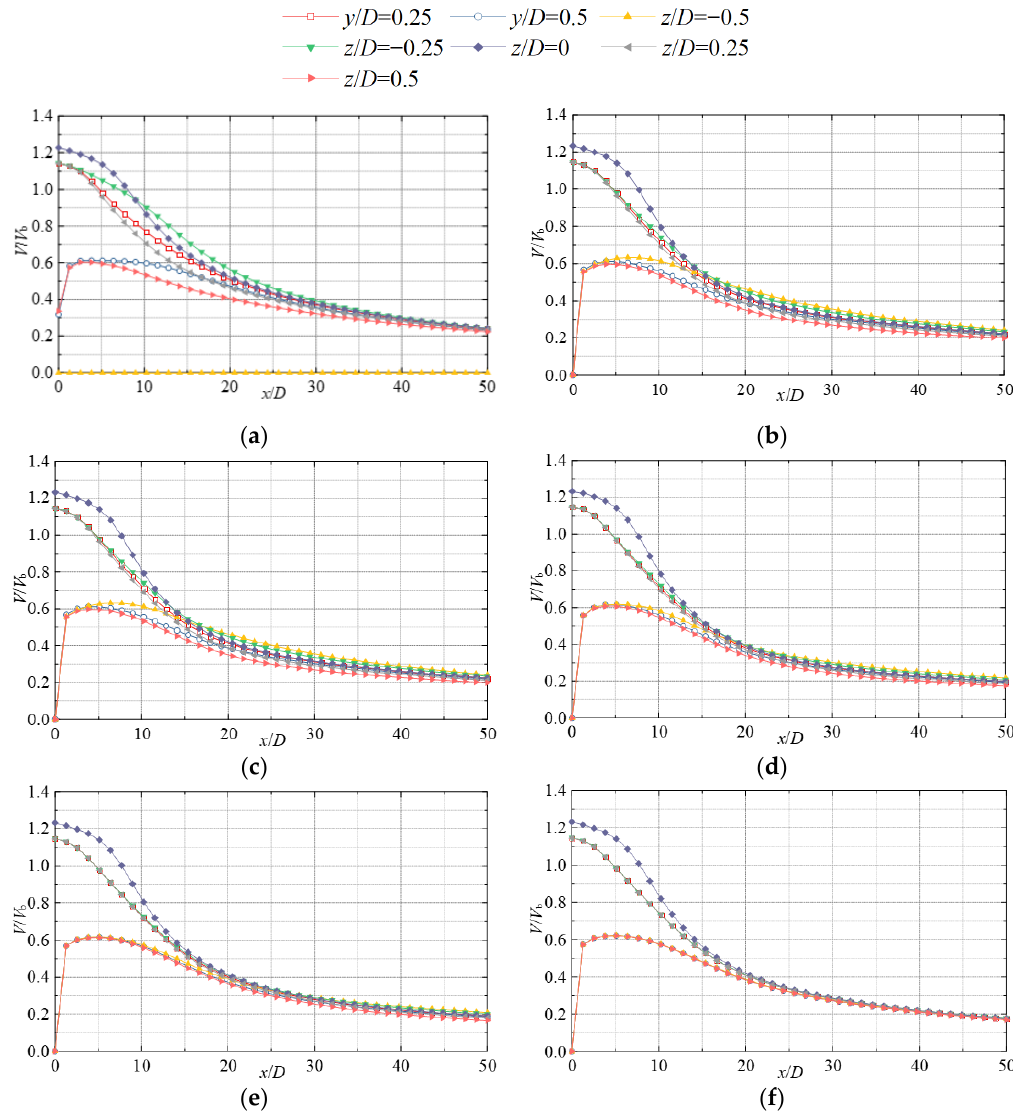
Figure 13. Distribution of V / V b at different y / D and z / D positions at different horizontal heights H / D : ( a ) H / D = 0.5; ( b ) H / D = 0.75; ( c ) H / D = 1; ( d ) H / D = 1.5; ( e ) H / D = 3; and ( f ) H / D = 4.